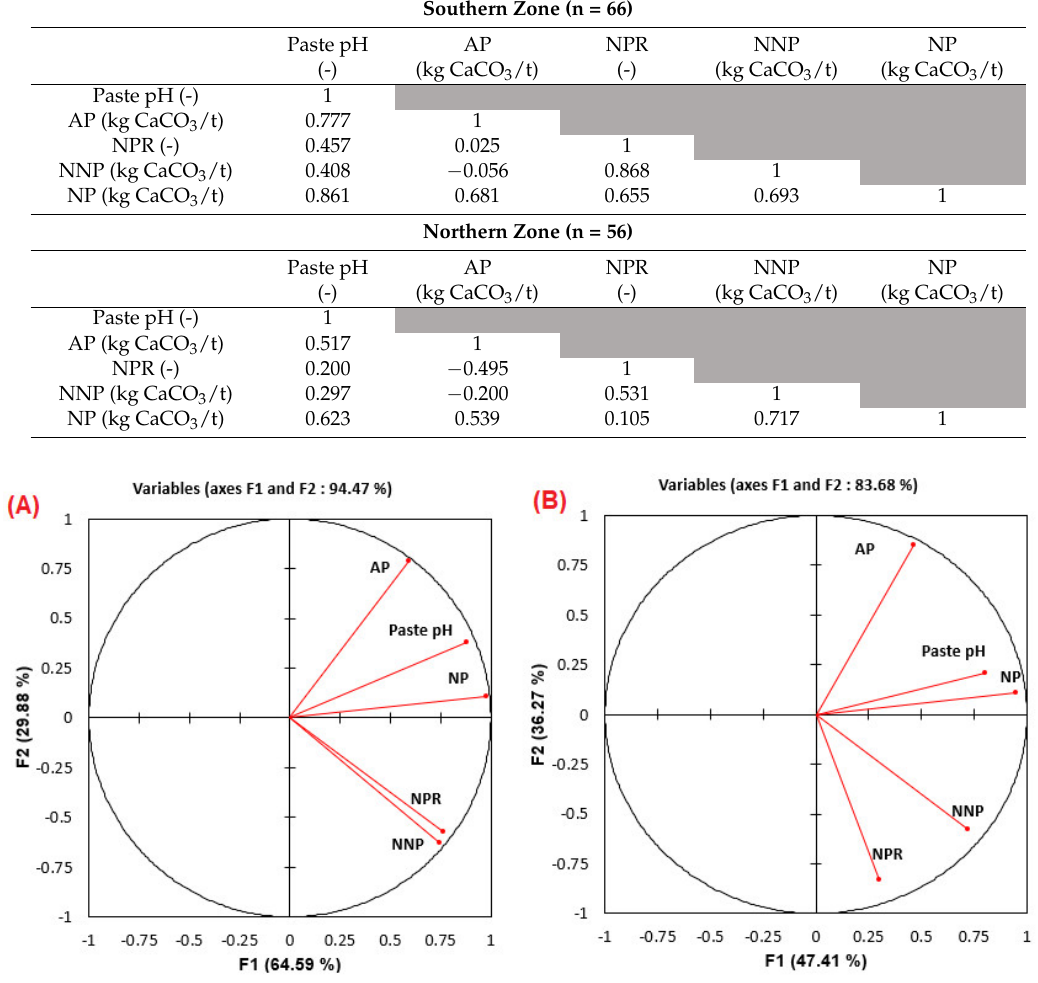
Table 3. Correlation matrices relating paste pH with AP, NPR, NNP, and NP for the southern and northern zones ( p < 0.05).